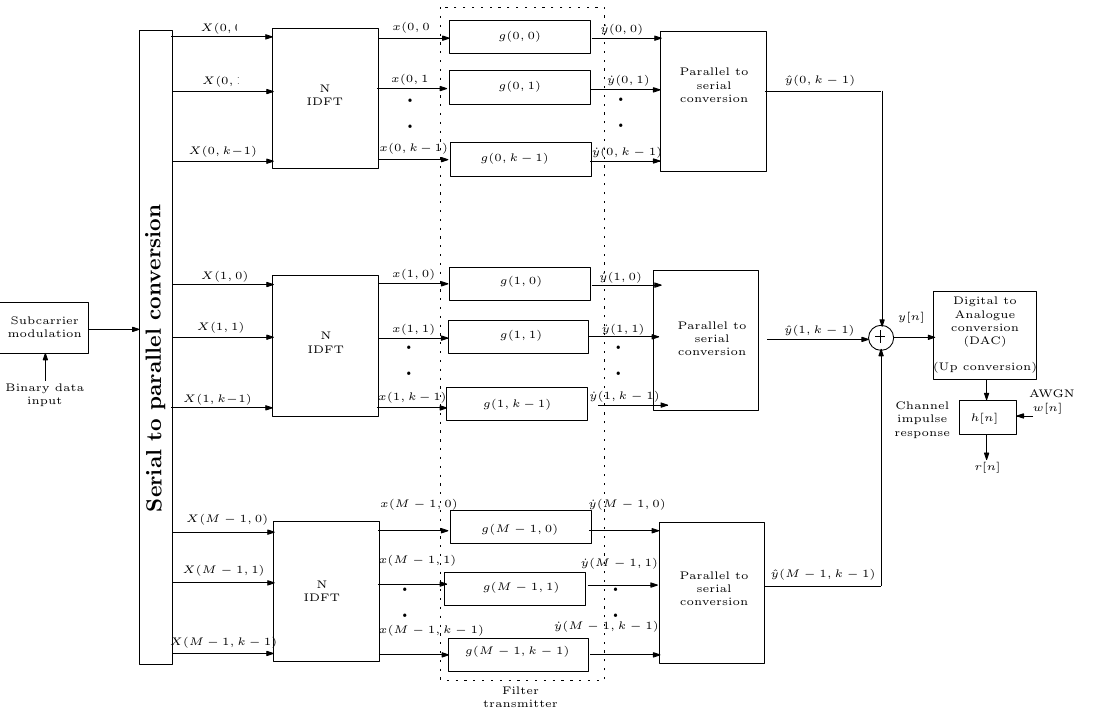
Figure 10. Transmitter structure of UFMC